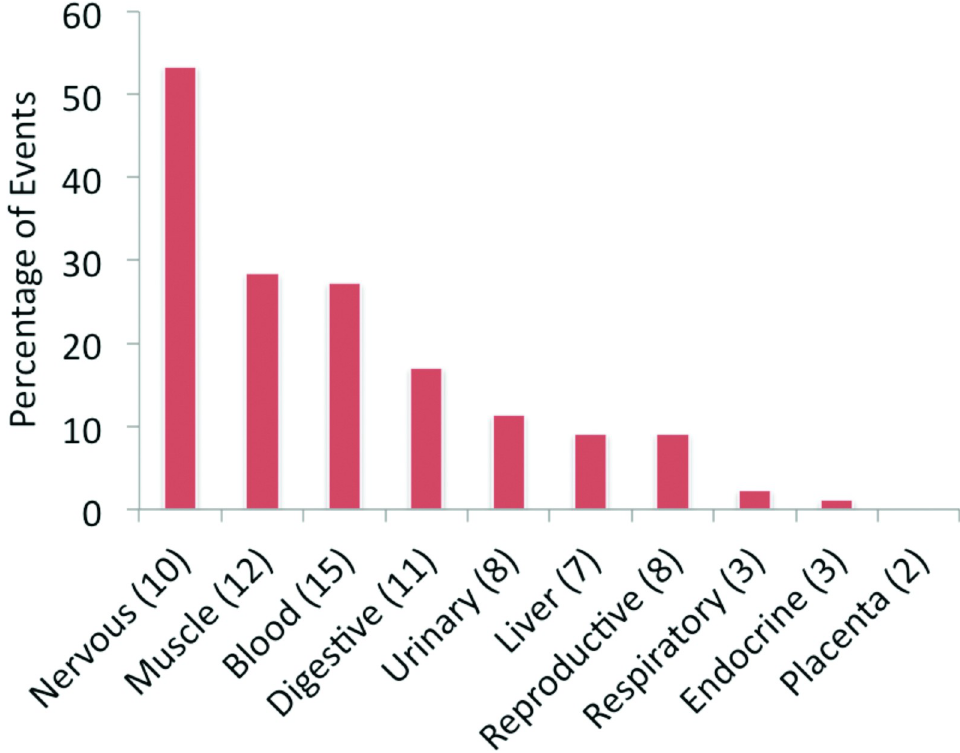
Fig 1. Tissue-specific alternative splicing events at the proteomics level. The percentage of significant tissue-specific alternative splicing events across the 10 proteomics tissue groups. The number of experiments for each tissue group is shown in the x-axis